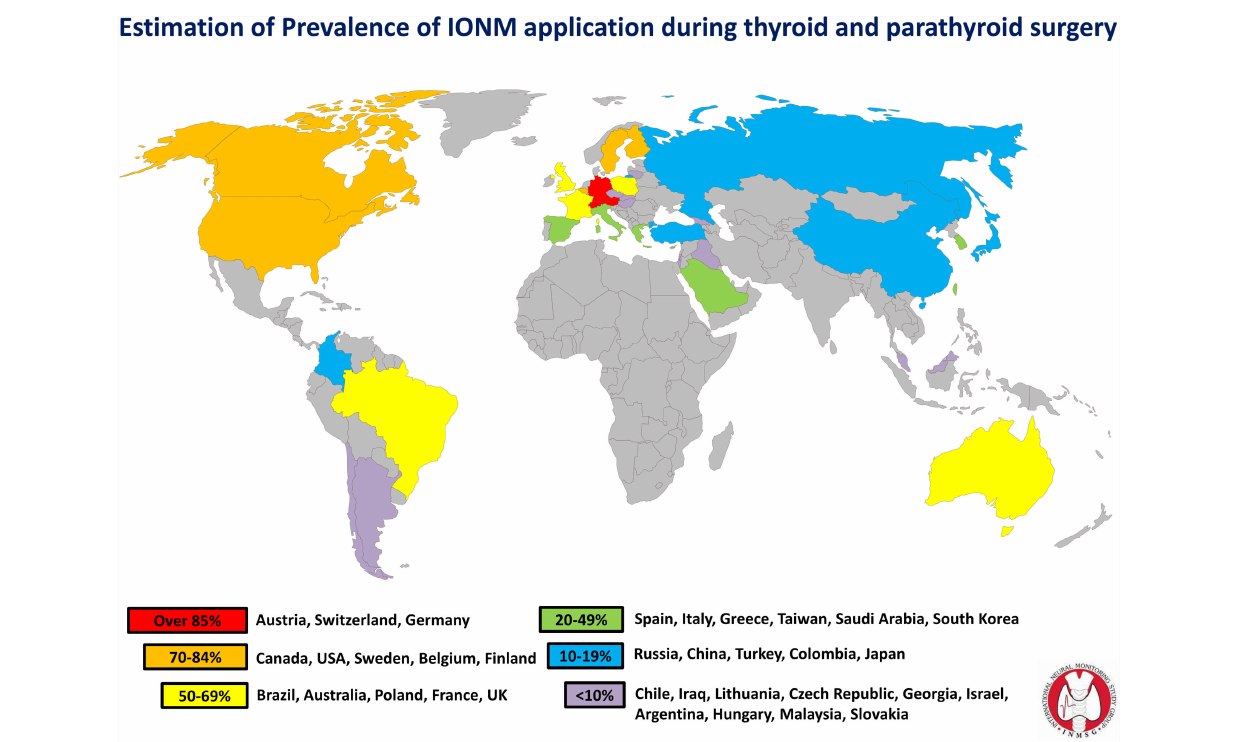
FIGURE 1 | IONM use estimation by country (Source: First World Congress Of Neural Monitoring In Thyroid And Parathyroid Surgery. 17-19, September 2015, Krako ́ w, Poland. http://ionmworldcongress.com/- courtesy of Inomed Medizintechnik GmbH, Emmendingen Germany. World map by